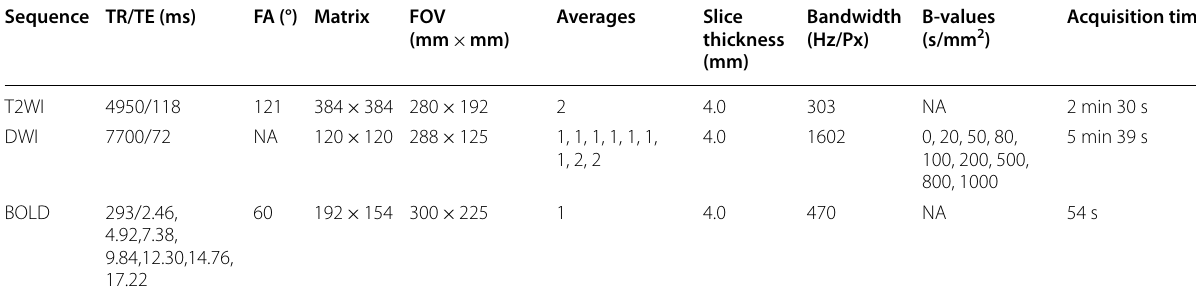
Table 1 MRI acquisition parameters at 3.0